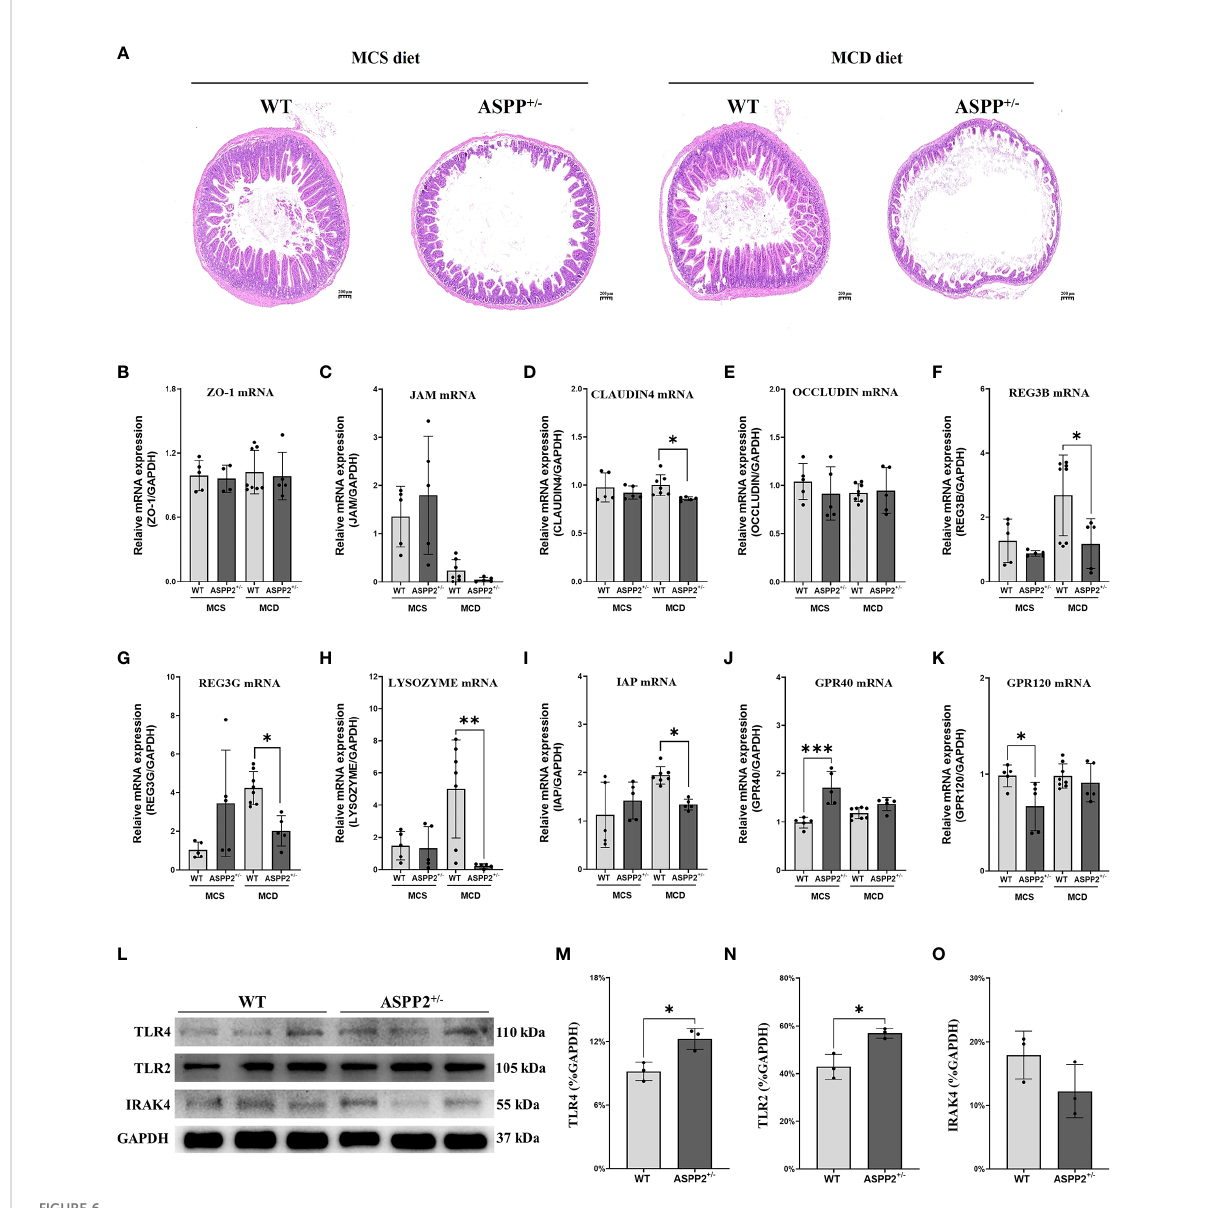
FIGURE 6 MCD and MCS diet for 10 days deteriorated intestinal barrier function and elevated the level of intestinal fatty acid receptors in ASPP2 +/- mice group. (A) Representative intestine H&E staining sections of WT and ASPP +/- mice induced by MCD or MCS diet for 10 days. (B – F) the mRNA expression levels of intestinal barrier function were measured in the indicated groups. (G – K) The mRNA expression levels of genes associated with intestinal fatty acid receptor. (L – O) The expression of TLR4, TLR2 and IRAK4 protein in the liver of WT and ASPP2 +/- mice. WT-MCS group, n=3-5; ASPP2 +/ – MCS group, n=3-5; WT-MCD groups, n = 3-8; ASPP2 +/ – MCD groups, n = 3-8. *p < 0.05; **p<0.01;